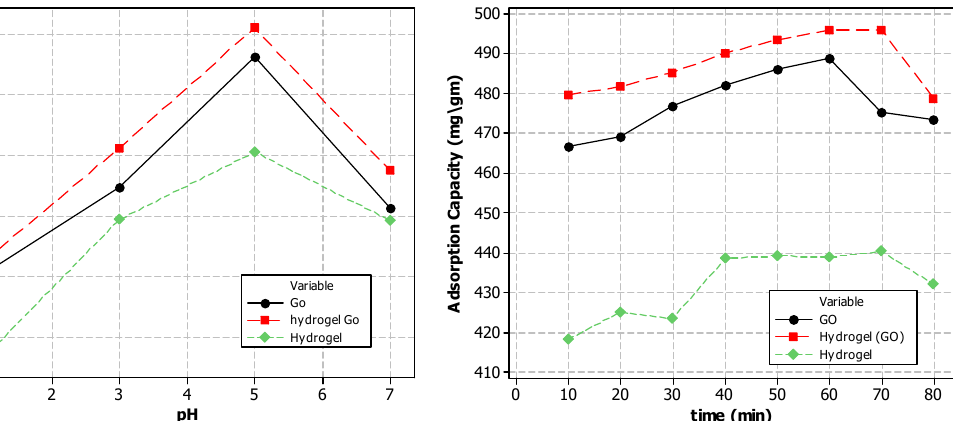
Fig. 6: Effect of initial solution pH on adsorption uptake of Cu(II) (initial Cu(II) concentration 500 mg l –1 , dosage of GO 100 mg l –1 , contact time 60 min)